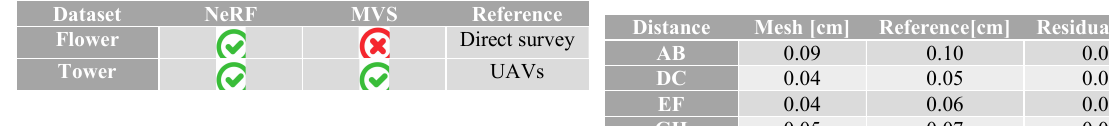
Table 1 . Summary of the reconstruction methods applied to the two case studies: success/failure of each attempt is provided.